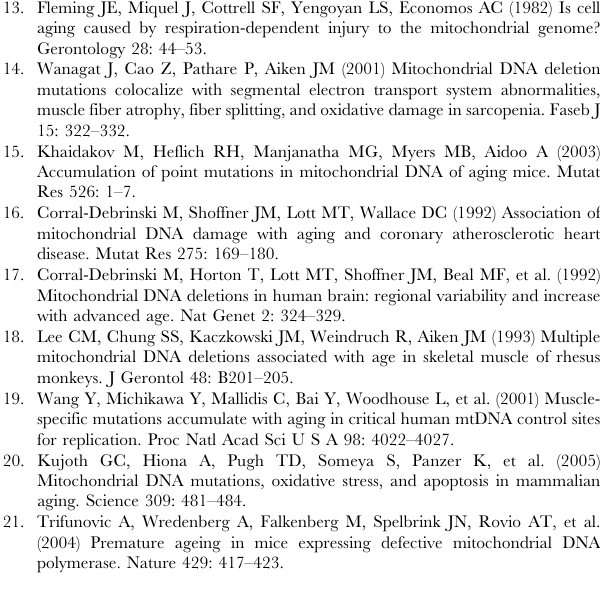
Table S1 Gene expression changes in gastrocnemius muscle of 13-month-old D257A mice compared to wild type mice. Figure S1 No differences between WT and D257A skeletal muscle in mitochondrial respiration at 3-mo of age. We determined the effects of mtDNA mutations on O2 consumption of skeletal muscle mitochondria obtained from 3-mo old (n= 8 per group) WT and D257A mice. The respiratory control ratio (RCR), an index of mitochondrial coupling and metabolic efficiency of mitochondrial preparations, was calculated by dividing state 3 by state 4 respiration values. No statistically significant differences were detected. Error bars represent SEM. Figure S2 No differences in total basal and site-specific reactive oxygen species production at 3-mo of age. Skeletal muscle mitochondria were obtained from 3-mo old (n= 8 per group) WT and D257A mice. We evaluated H2O2 production at complex I in mitochondria supplemented with pyruvate/malate (panel A) because it represents total basal mitochondrial ROS generation. We also used inhibitors of the ETC in order to study maximum rates of H2O2 production from complexes I and III because they represent the main sites of ROS generation within